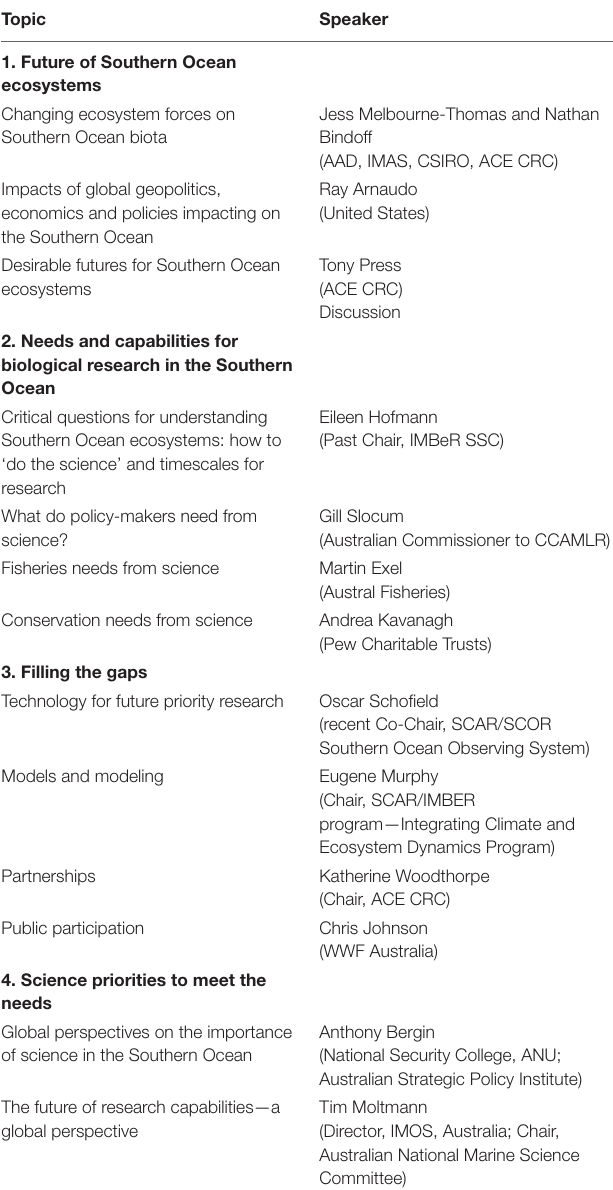
TABLE 1 | Sections and topics presented and discussion at the Policy Forum in the conference Marine Ecosystem Assessment for the Southern Ocean, held in Hobart Australia on 11 April